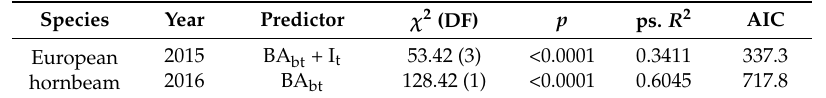
Table 5. The goodness of fit characteristics of the number of dead new sprouts model. Table 6. The parameter estimates for the best model fit of the number of dead new sprouts.